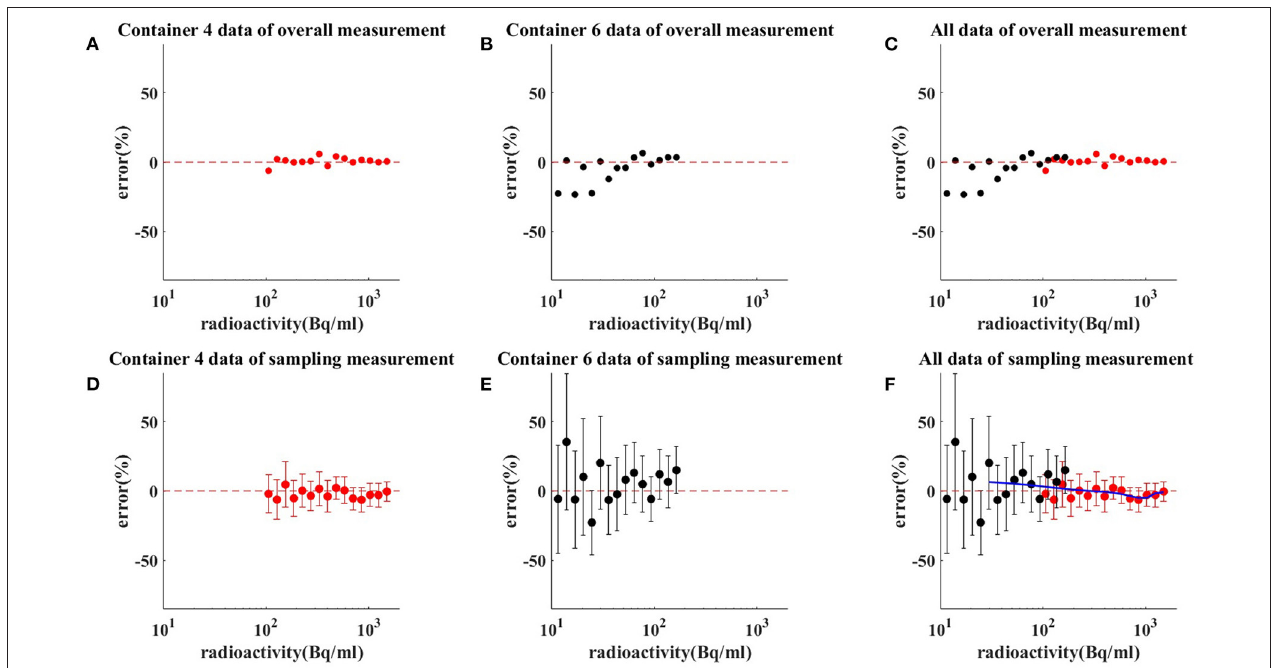
FIGURE 3 | Results of measuring radioactivity by method 1 (C) and method 2 (F) . Red dot and red bar represent the mean radioactivity error and the standard error of container 4 (A,D) , respectively. Black dot and black bar represent the mean radioactivity error and the standard error of container 6 (B,E) , respectively. When radioactivity between 11.1–111, 111–370, and 370–1,480 Bq/mL, the mean activity errors of the overall measurement were 8.83, 2.04, and 1.45%, respectively. When radioactivity between 11.1–111, 111–370, and 370–1,480 Bq/mL, the mean activity errors of sampling measurement were 4.1 ± 26.43, 2.69 ± 14.6, and 1.60 ± 8.73%, respectively. The blue line is the radioactivity error fitted curve for ULA.